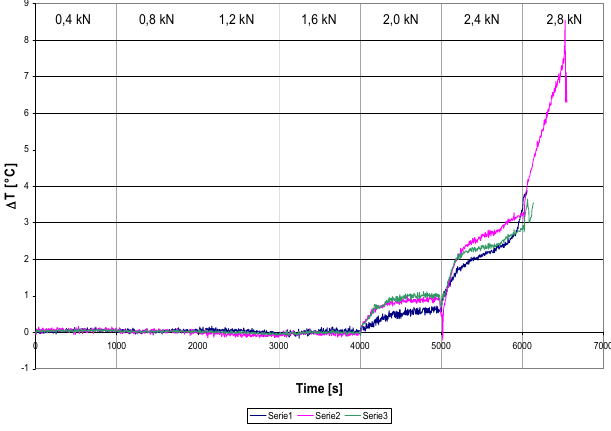
Figura 11: Profilo termico e limite di fatica in corrispondenza del quarto step di